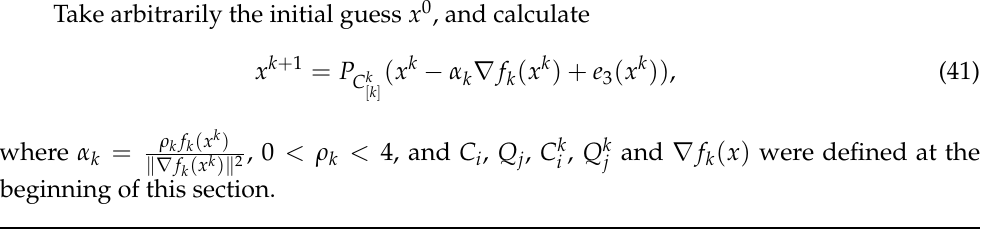
Algorithm 2 (The relaxed CQ algorithm with self-adaptive step size and